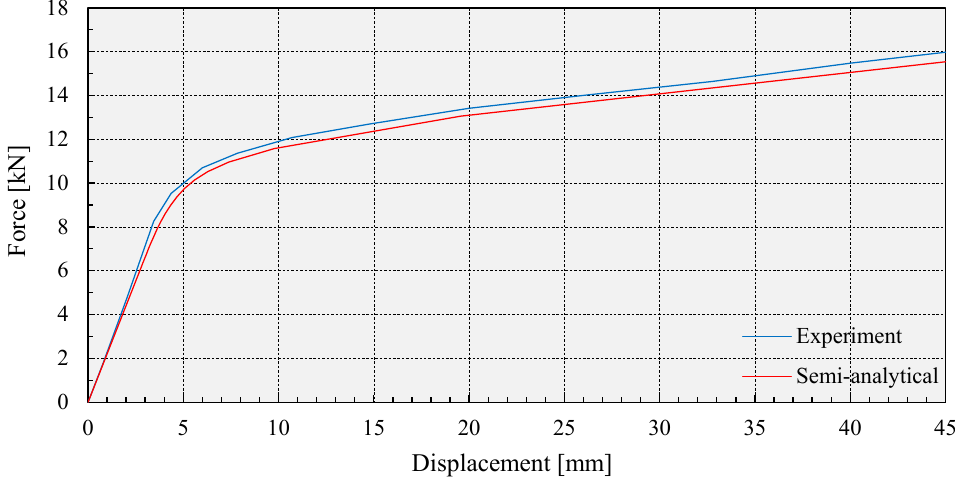
Figure 7. An experimental test setup of vertical components of the energy dissipation device.